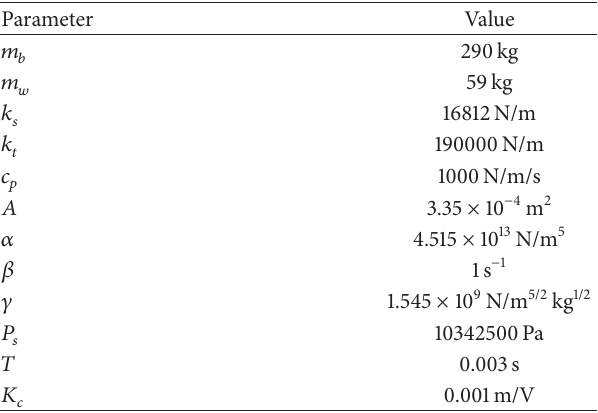
Table 1: Parameter values of the active suspension system.